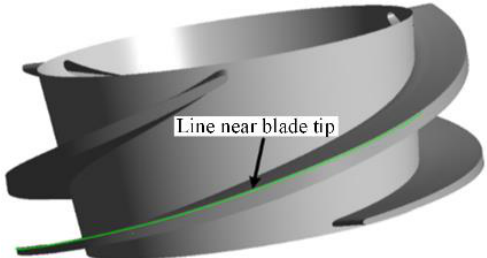
Figure 13. Line near blade tip.